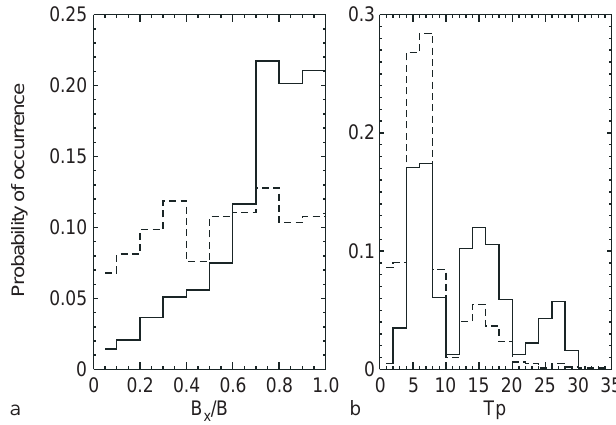
Fig. 10a, b. Histograms of the probability of occurrence of the IES (region III of Fig. 2a; solid line ) and wave packets (region I of Fig. 2a, dashed line ) as functions: a of the modulus j B X = B j of the cosine of the angle between the B field and the Earth-Sun direction. b Of the proton temperature in eV. Each histogram is normalised to its total number of